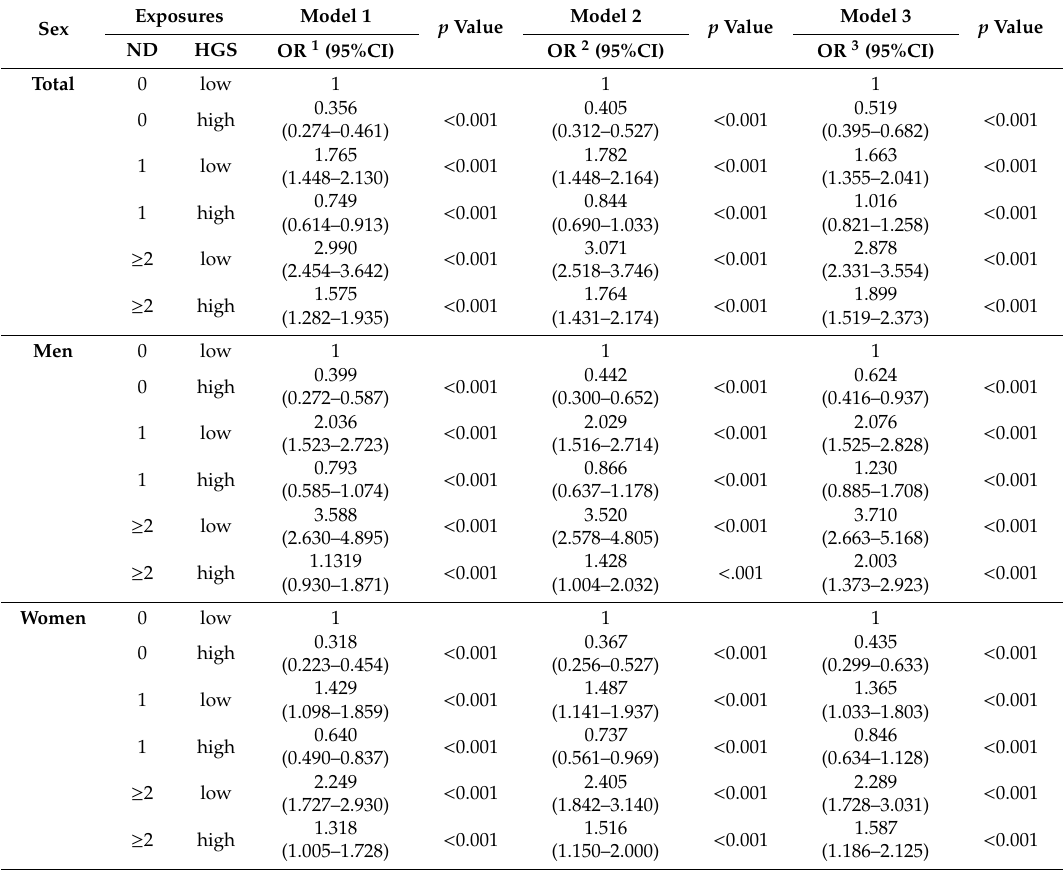
Table 4. Combined e ff ects of handgrip strength and the number of diseases on